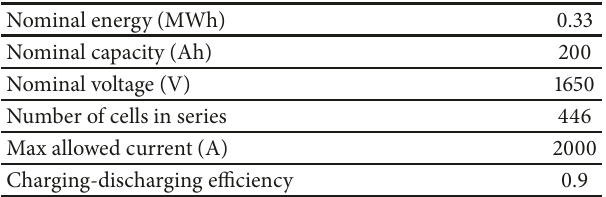
Table 1: Input model parameters of the system under study. Table 2: Lithium battery main characteristics.